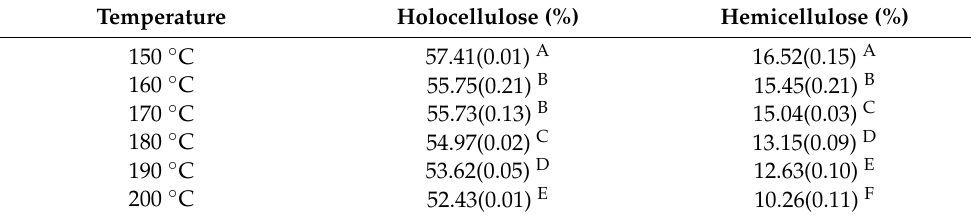
Table 3. The holocellulose content at different hot press temperature conditions.